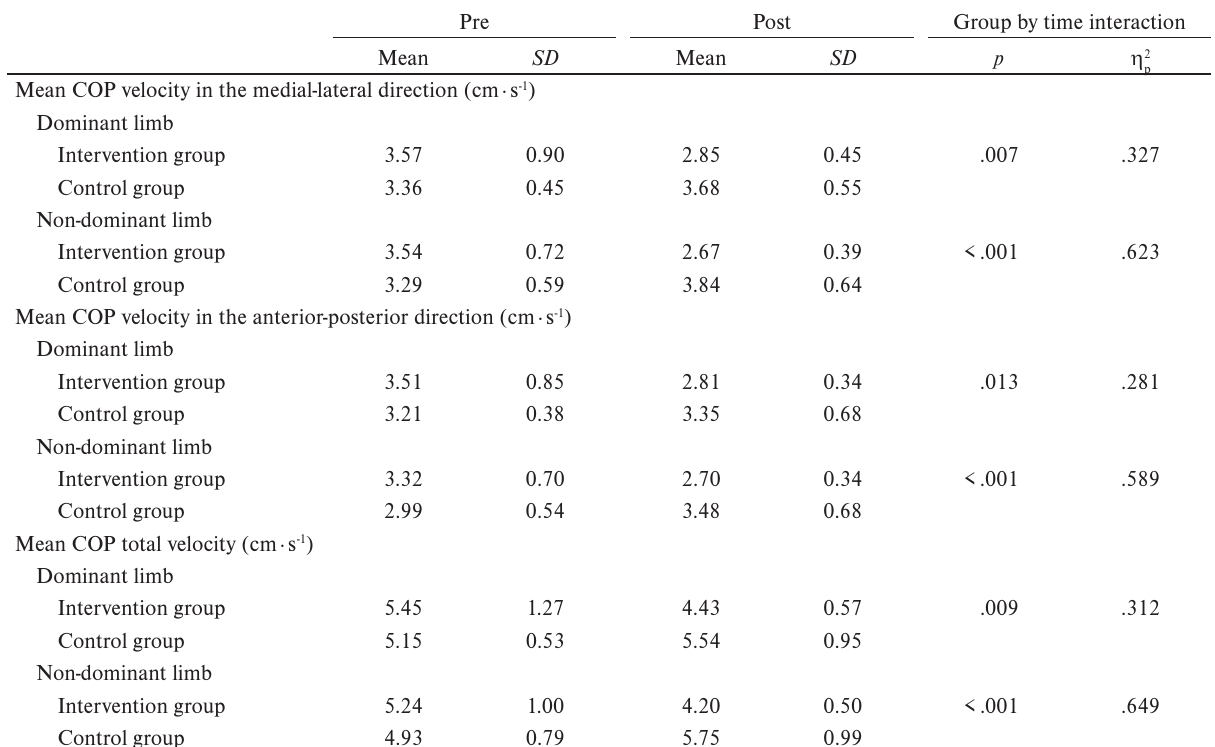
Comparison of the results of basic COP velocity parameters of unilateral postural stability task for dominant and non- dominant limb in control and intervention